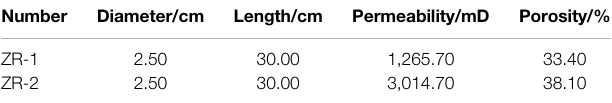
TABLE 3 | Basic parameters of experimental cores.